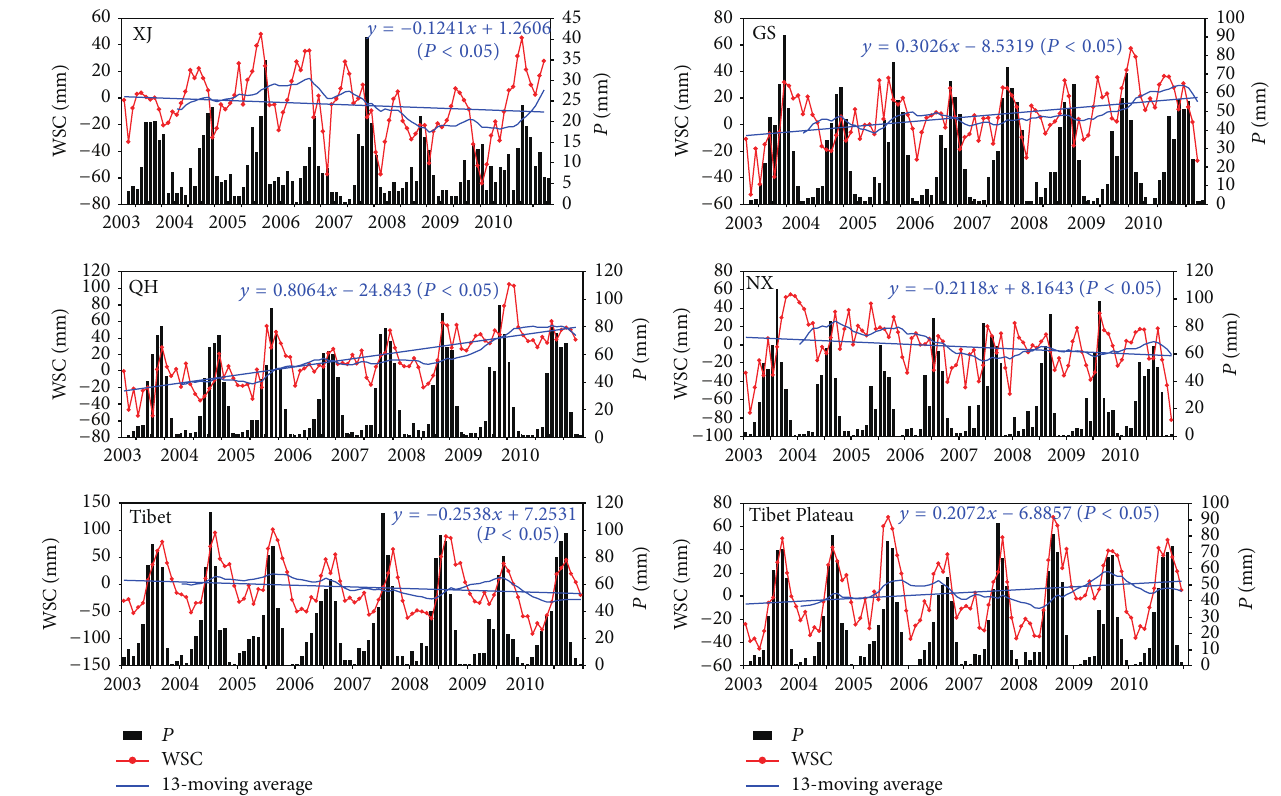
Figure 8: Time series of WSC and precipitation ( 𝑃 ) over each of the study areas from 2003 to 2010.